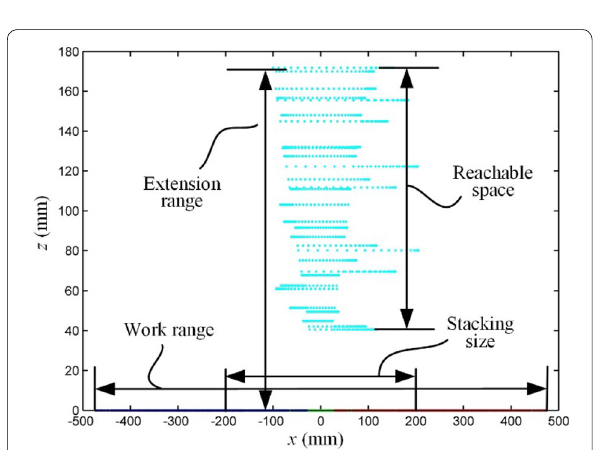
Figure 22 Fold‑extension ratio diagram of the multiarm